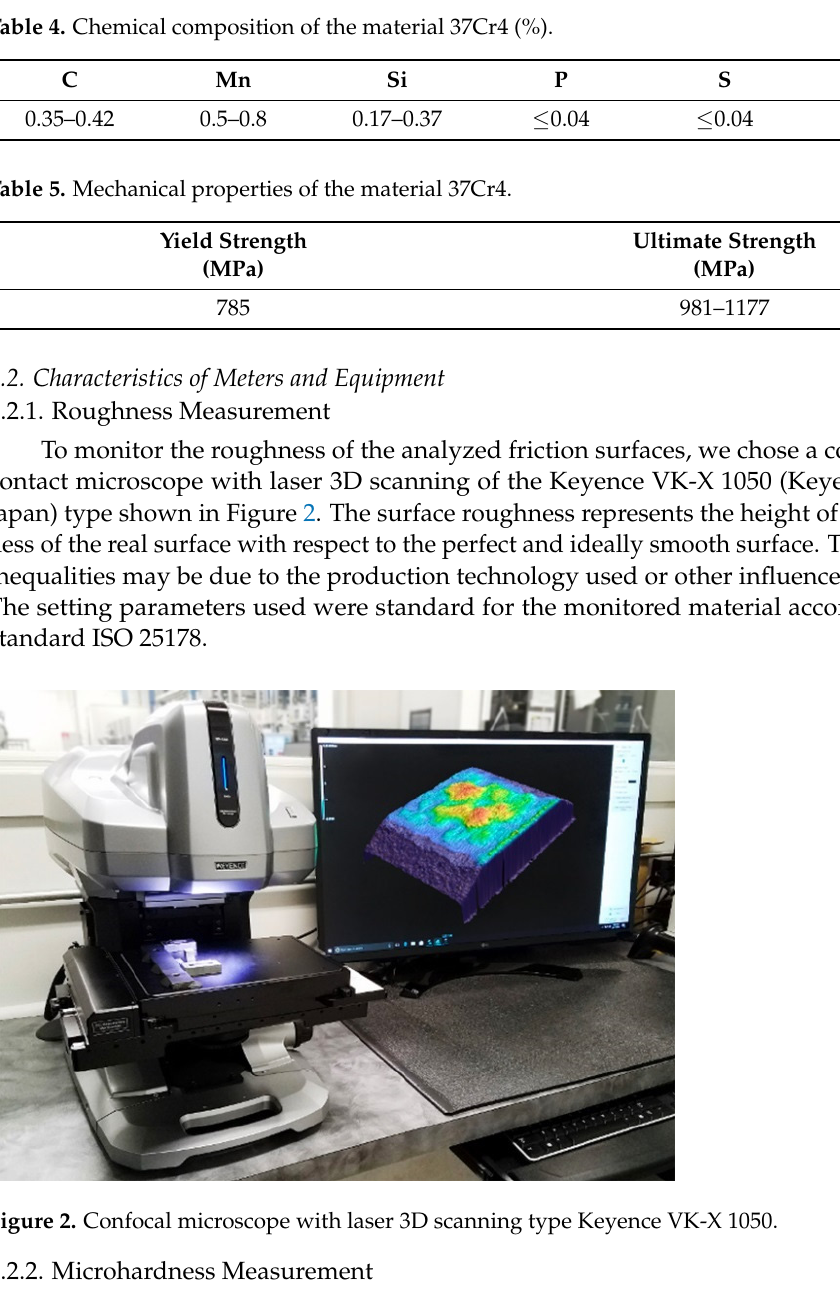
Table 4. Chemical composition of the material 37Cr4 (%).